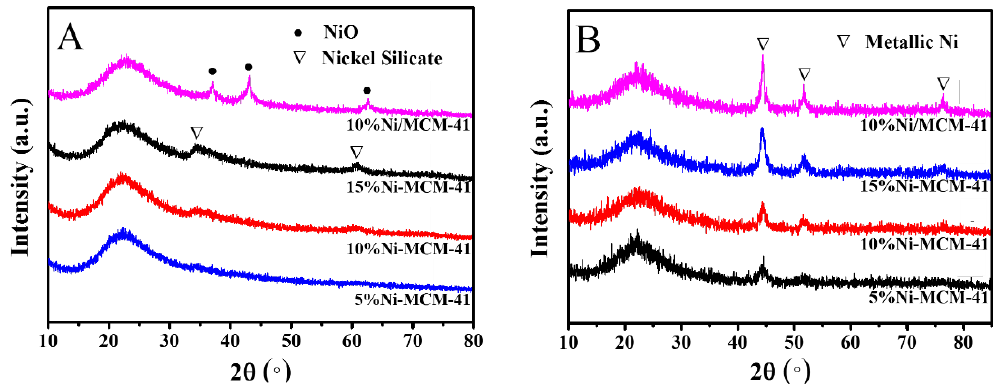
Figure 2. Wide-angle XRD patterns of fresh catalysts ( A ) and reduced catalysts ( B ).